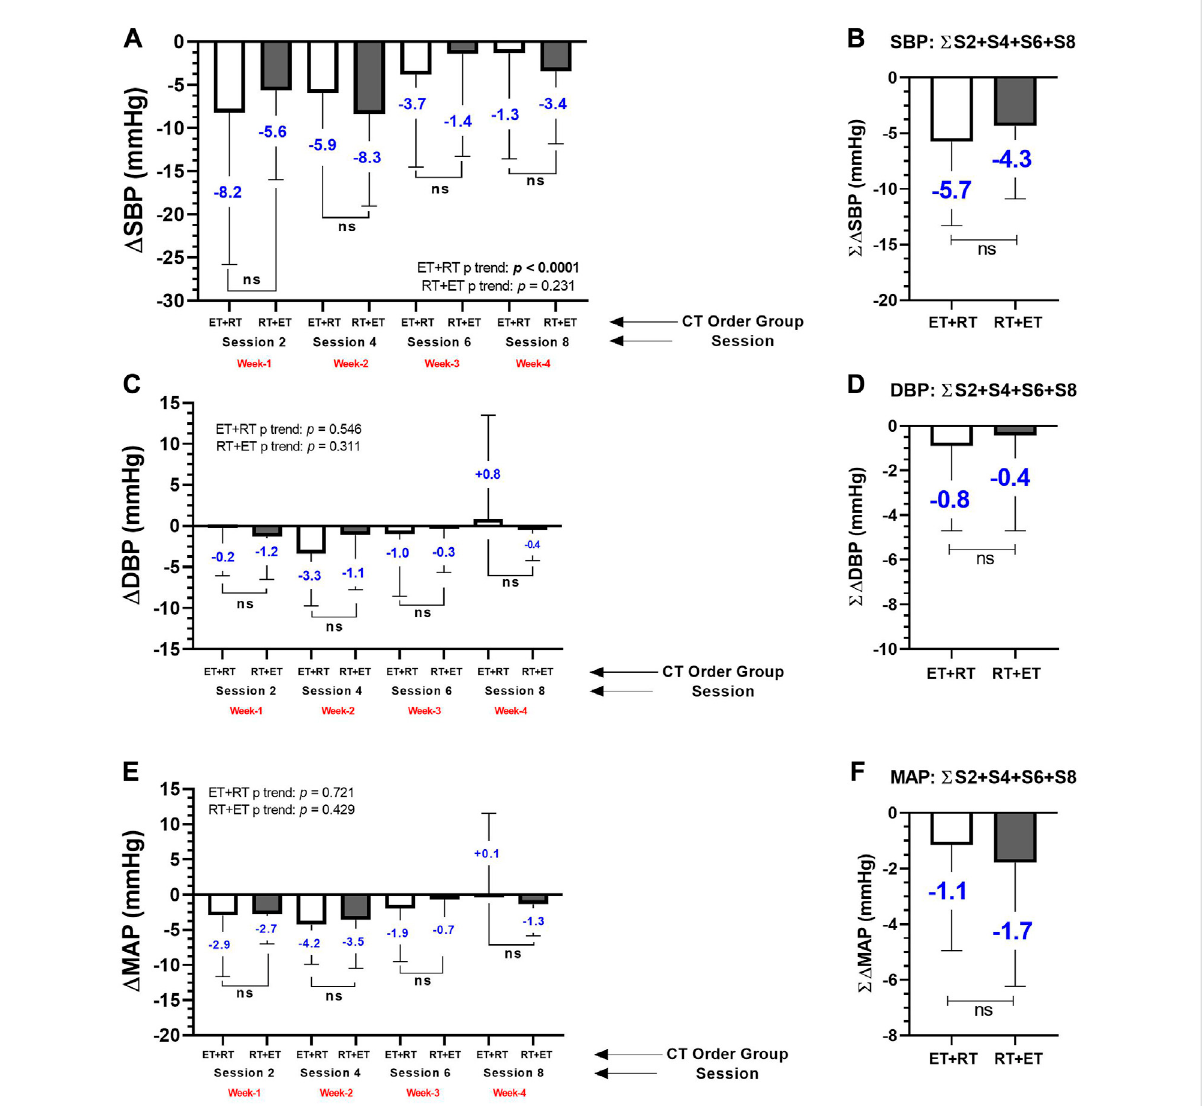
FIGURE 3 Postexercisehypotensiveeffectinsystolicbloodpressureby eachdeltachangesbysession (A) ,andbythesum of4exercisesessions (B) ,indiastolicblood pressurebyeachdeltachangesbysession (C) ,andbythesumof4exercisesessions (D) ,andinmeanarterialpressurebyeachdeltachangesbysession (E) , andbythesumof4exercisesessions (F) during4weeks(eightexercisesessions)monitoredfourtimesduringsession2(secondCTsession),session4(fourth CTsession),session6(sixthCTsession),andsession8(eightCTsession)inmorbidobesitypatients ’ participantsoftwoordergroupsofconcurrenttraining. Groups are described as (ET + RT) endurance training plus resistance training group and (RT + ET) resistance training plus endurance training group. Outcomes are described as ( Δ SBP) delta of systolic, ( Δ DBP) delta of diastolic, and ( Δ MAP) delta of mean arterial pressure. (A) Δ SBP decreases after four exercise sessions in each CT exercise group. (B) . The average (i.e., S2+S4+S6+S8) of these four measurements in each group, are abbreviated as (cid:1) Δ SBP (B) , being the same abbreviation as (cid:1) Δ DBP (D) and (cid:1) Δ MAP (F) . (ns) denotes no signi fi cant differences p >